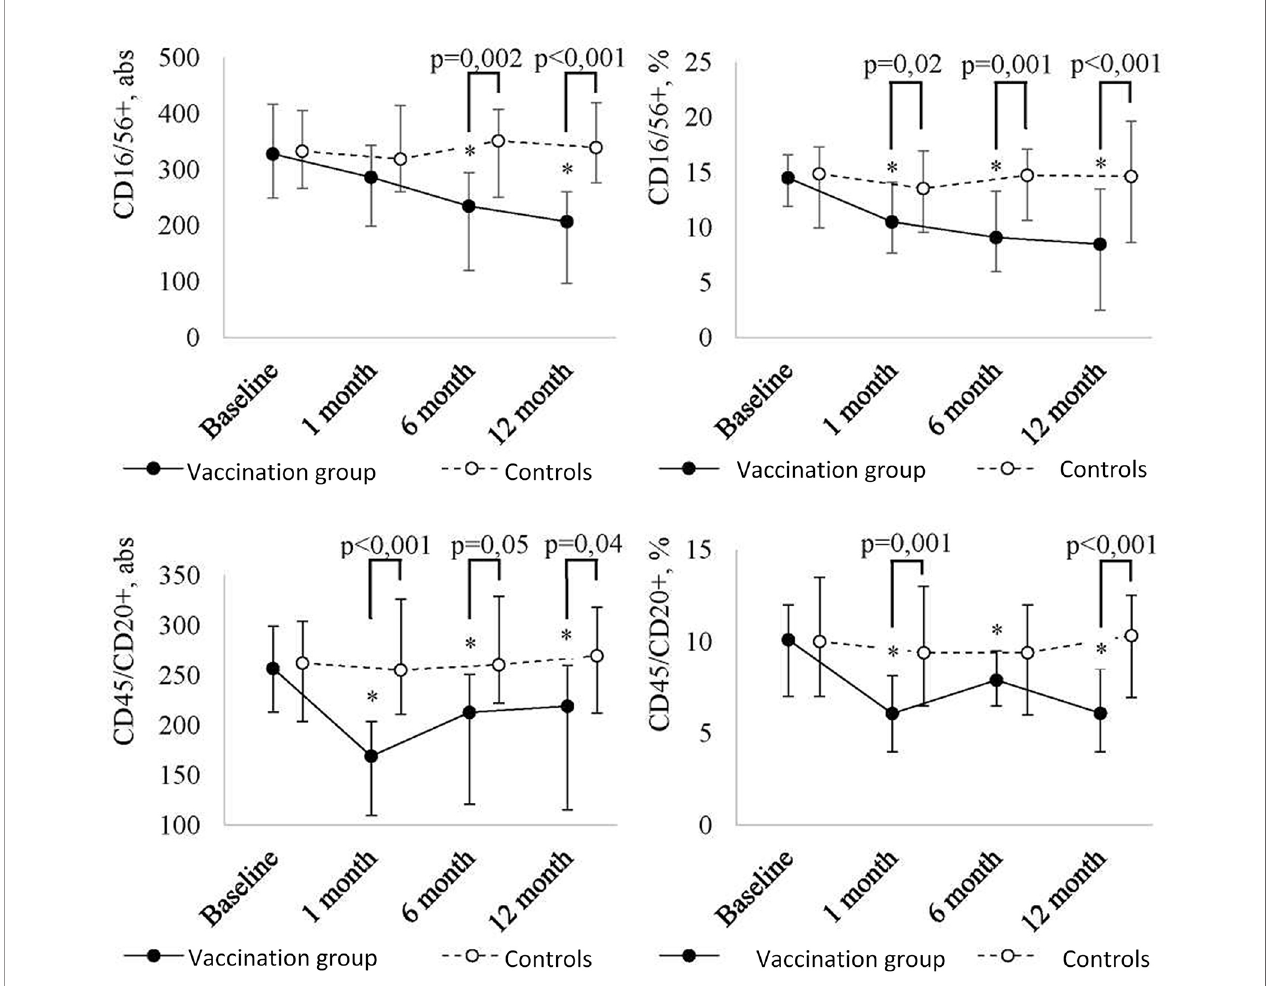
FIGURE 2C | Peripheral blood NK cell (CD16/56+) and B cell (CD45/CD20+) level dynamics in children with a history of solid tumors in the study group (after the revaccination with the ADS-m toxoid, n = 26) and the control group (n = 15), the median and the interquartile range are shown [Me (Q1-Q3)]. *statistically signi fi cantly different from the pre-vaccination value (p ≤ 0.05). To analyze alterations, the post-hoc Demsar test was used with a statistically signi fi cant Friedman omnibus test. Study groups were compared with the Mann-Whitney